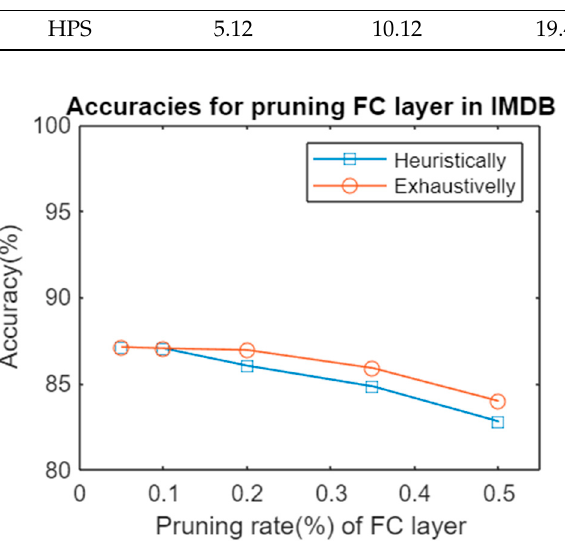
Figure 3. Accuracies for pruning an FC layer in the alternative architecture heuristically vs. pruning exhaustively.